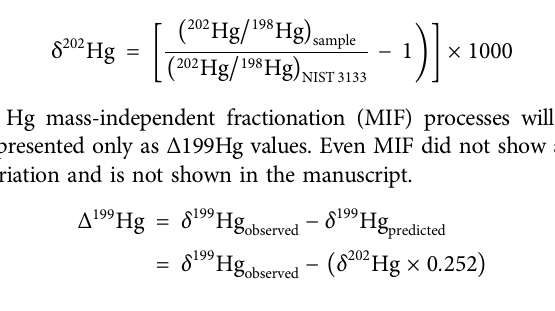
Frontiers in Environmental Chemistry |